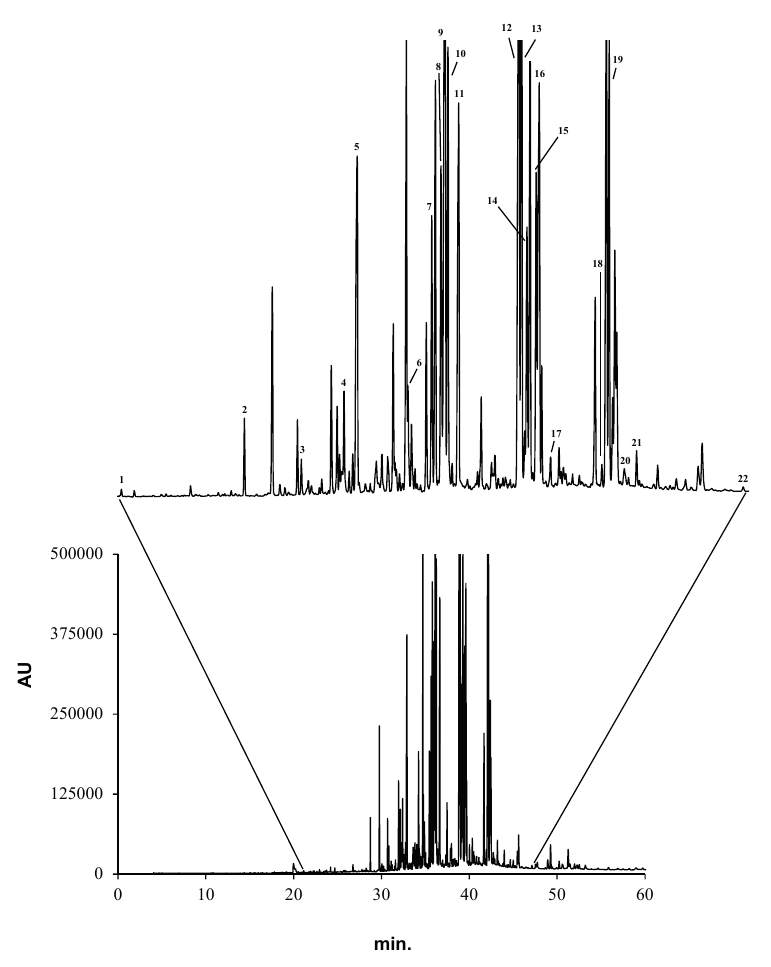
Figure 2. GC-MS profile of the methanol extract from the digestive gland of A. depilans . Peaks are identified in Table